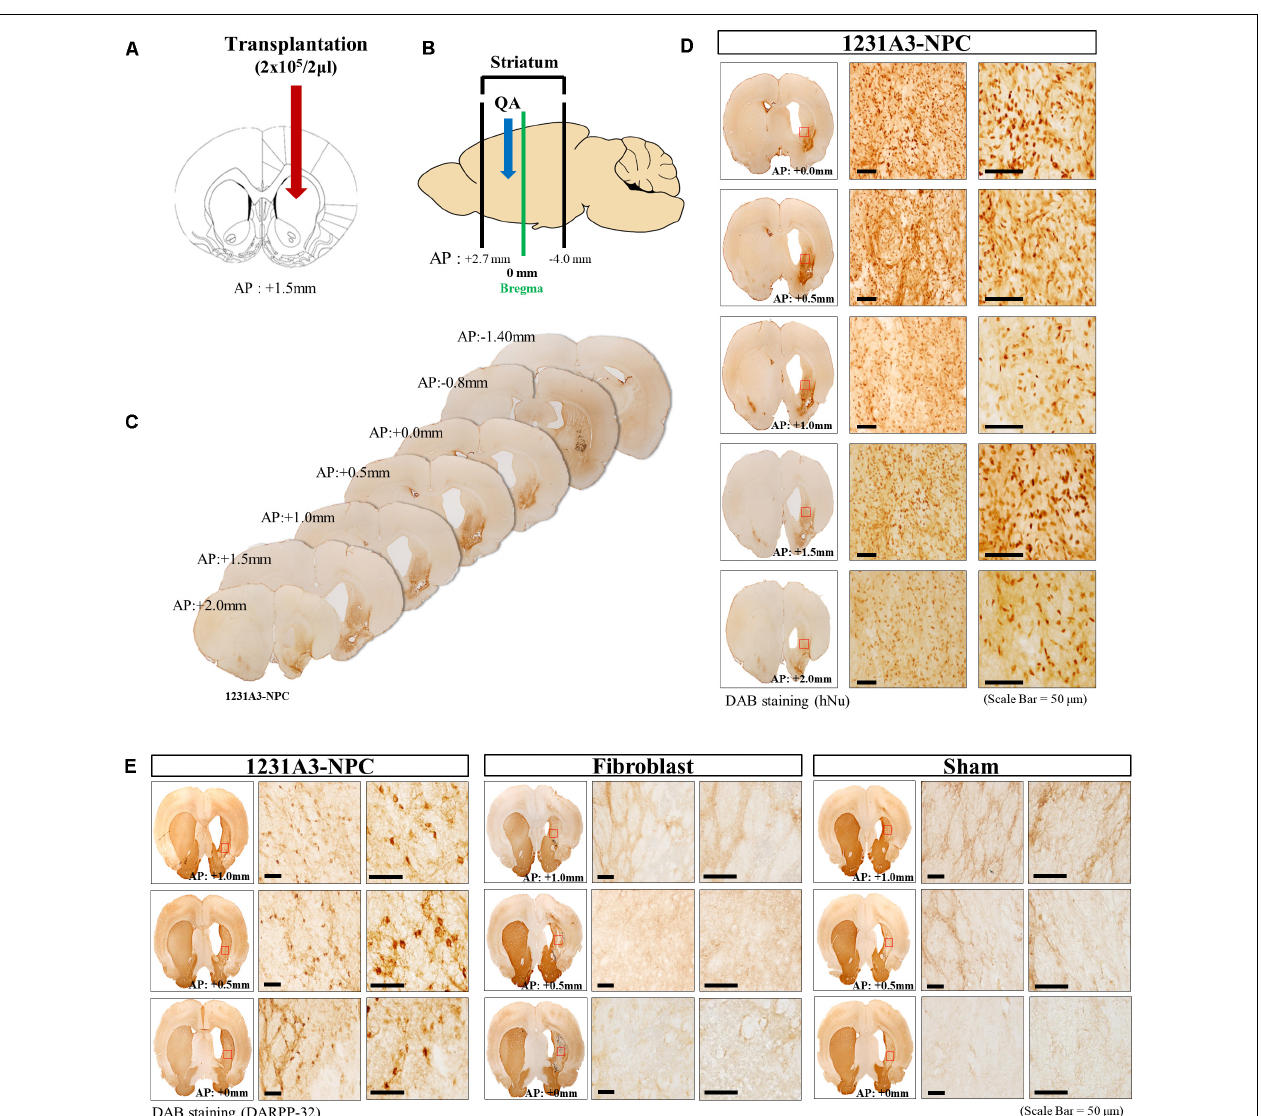
FIGURE 2 | Representative distribution patterns of transplanted 1231A3-NPCs and restoration of DARPP-32-positive cells in the QA-lesioned site. (A,B) Location of 1231A3-NPC injection and QA-lesioned striatum. (C) Serial brain sections of mice in the 1231A3-NPC TP group. (D) DAB IHC staining using an antibody against hNu in the QA-lesioned striatum. (E) DAB staining using an antibody against DARPP-32 in the QA-lesioned striatum. Scale bar = 50 µ m. NPC, neural precursor cell; QA, quinolinic acid; TP, transplantation; DAB, 3,3 (cid:48) -diaminobenzidine; IHC, immunohistochemical; hNu, human-specific nuclei; DARPP-32, dopamine- and cAMP-regulated neuronal